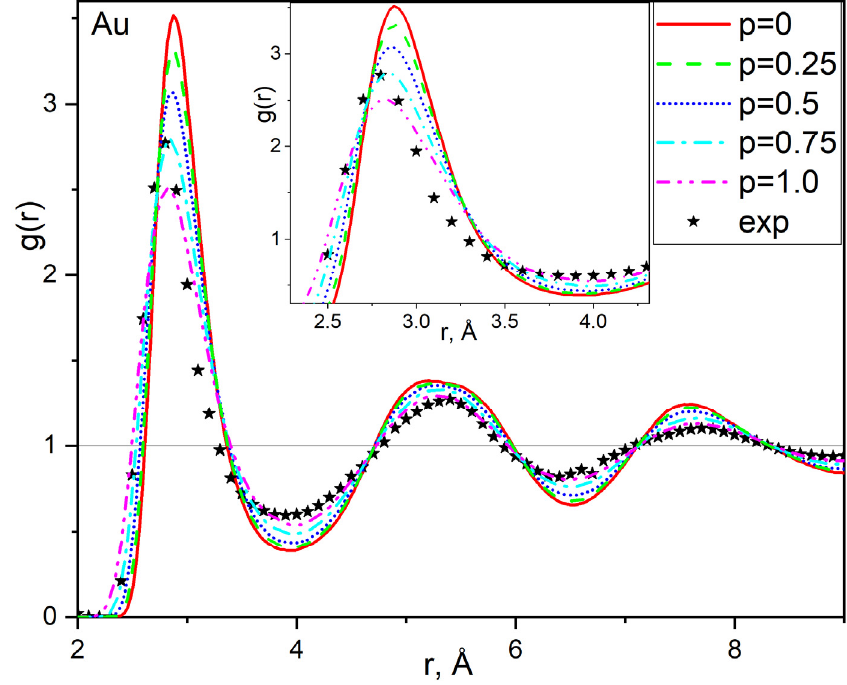
Figure 8. Pair correlation functions of liquid Au at T = 1423 K and different p in comparison with experiment [38].